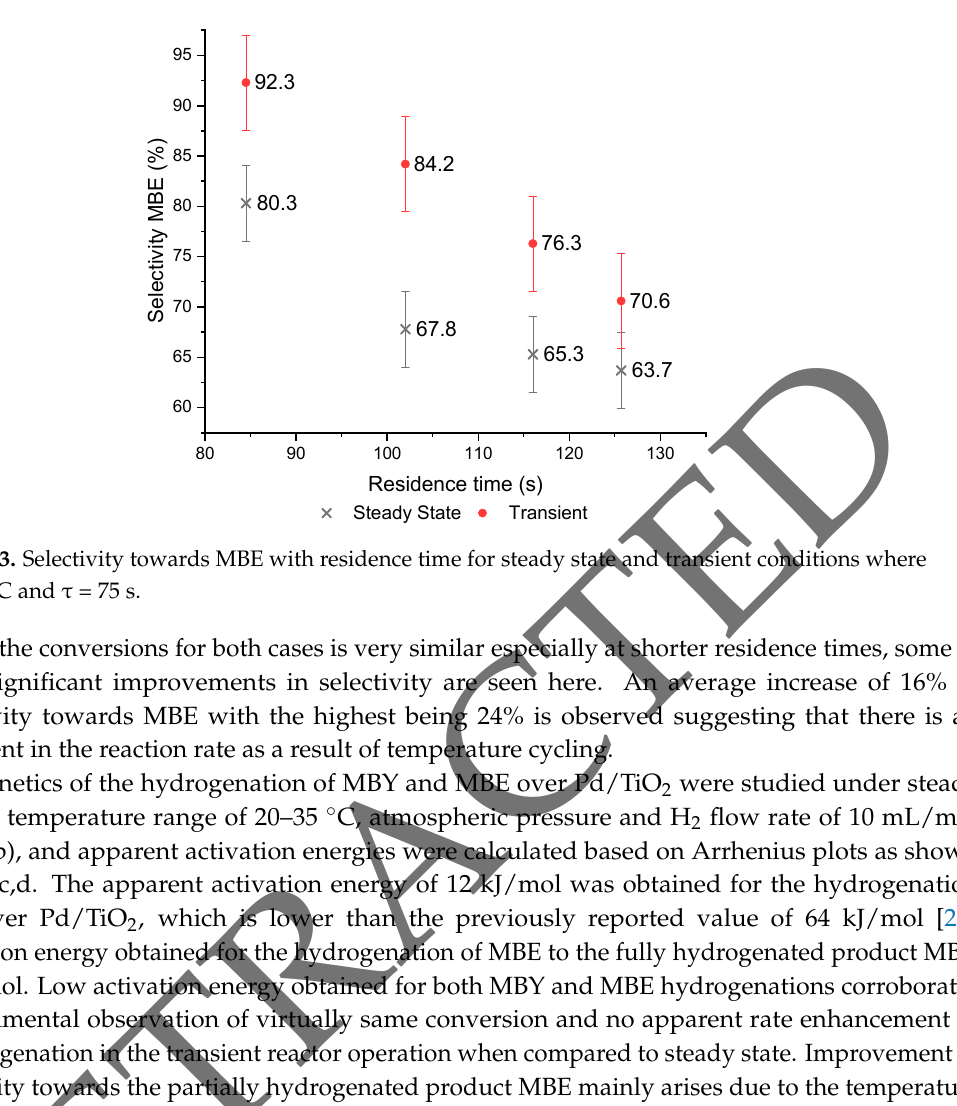
Figure 2. Conversion of MBY with residence time under steady-state and transient conditions where A = 5 °C and τ = 75 s.